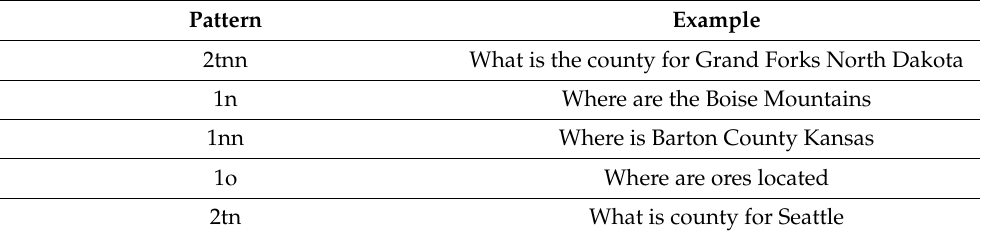
Table 2. Examples of encoding patterns adopted from [4]. Natural language can be translated into semantic encodings. For example, “Where are ores located” could be translated into “1o” (where: 1; ores: o). This semantic encoding does not capture the verb “located”. This illustrates that the semantic encoding-based approach is not able to capture the structure of the whole sentence. Furthermore, the pattern “1o” will not be changed if “ores” are changed into any other arbitrary words. That is, it could not capture the semantics of the sentence. These problems will be addressed by adopting the embedding-based topic modeling approach. Pattern Example 2tnn What is the county for Grand Forks North Dakota 1n Where are the Boise Mountains 1nn Where is Barton County Kansas 1o Where are ores located 2tn What is county for